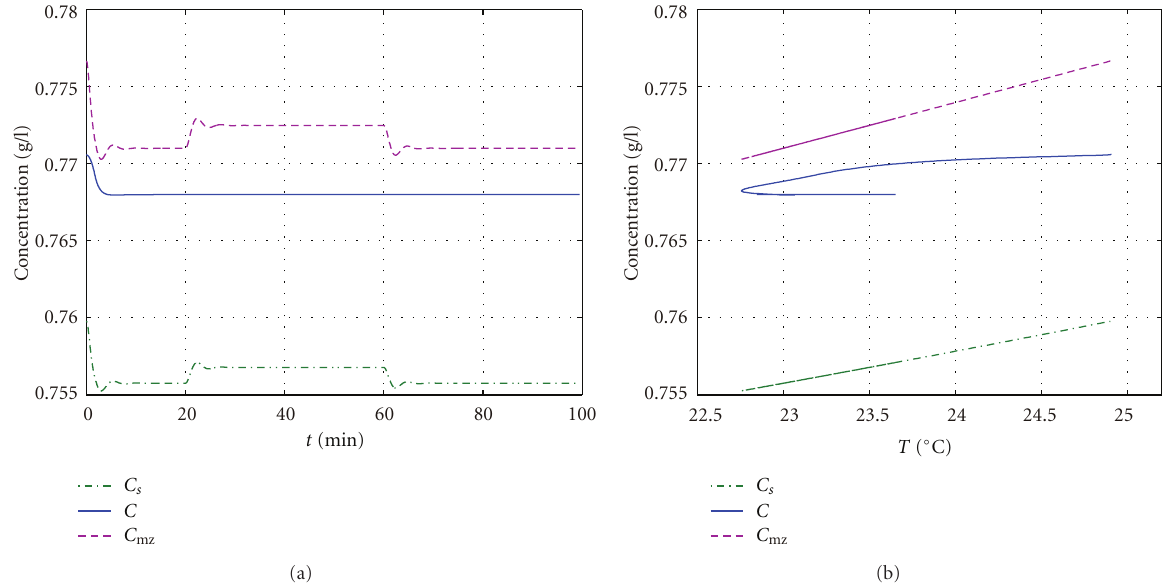
Figure 5: Concentration profiles inside the crystallizer when step changes are imposed to the output variable T .